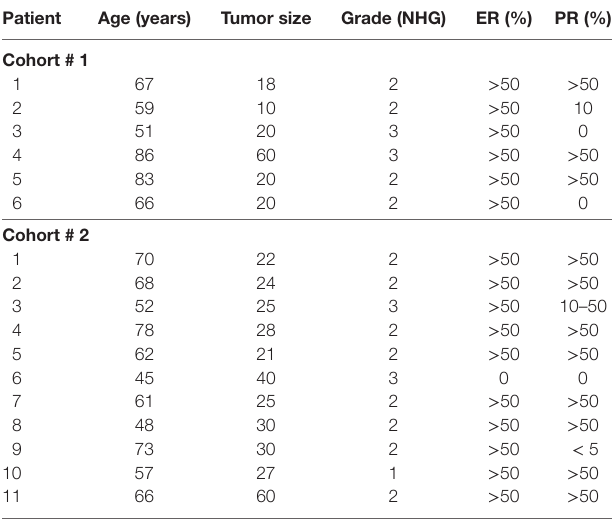
TaBle 1 | Characteristics of patients subjected to intratumoral